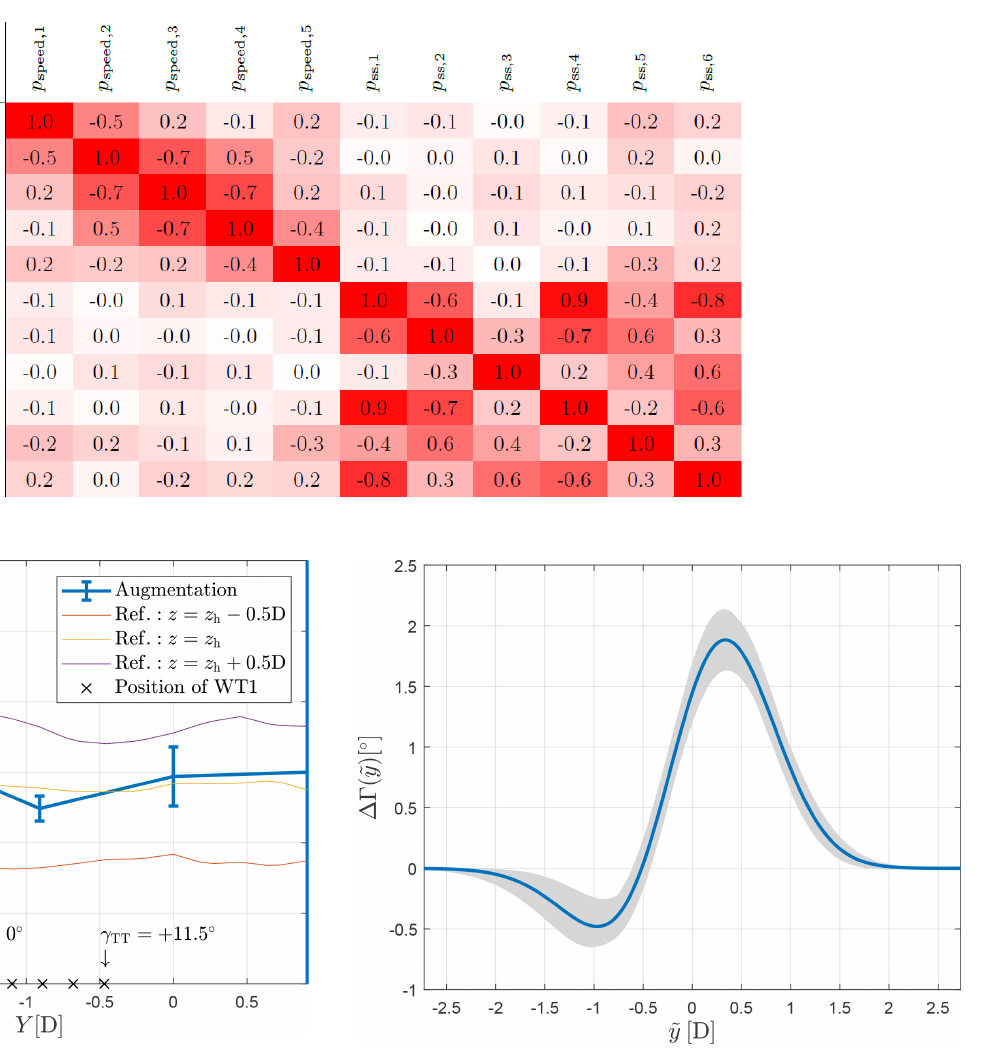
Figure 7. Identified nonuniform inflow speed augmentation term (solid line) and associated standard deviation (whiskers). Hot-wire measurements at different heights above the floor are shown in thin solid lines. The upstream turbine (WT1) y position for all investi- gated turntable rotations is shown by × markers placed along the lower edge of the figure.